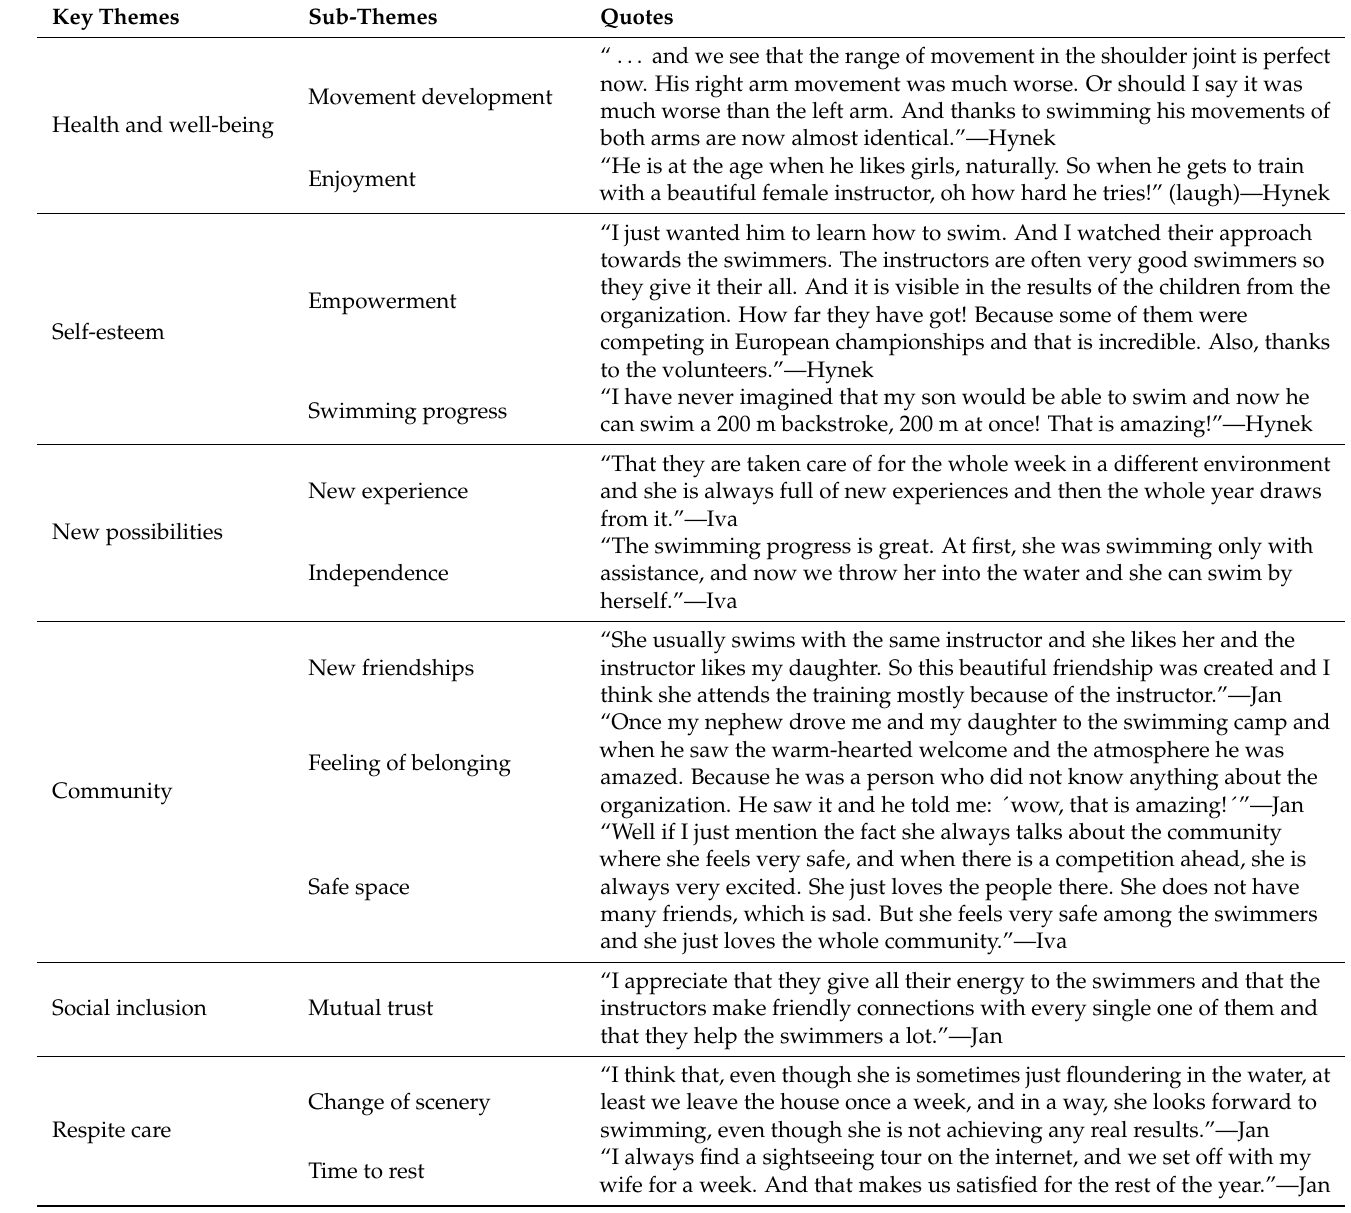
Table 5. Parent’s quotes according to the mentioned